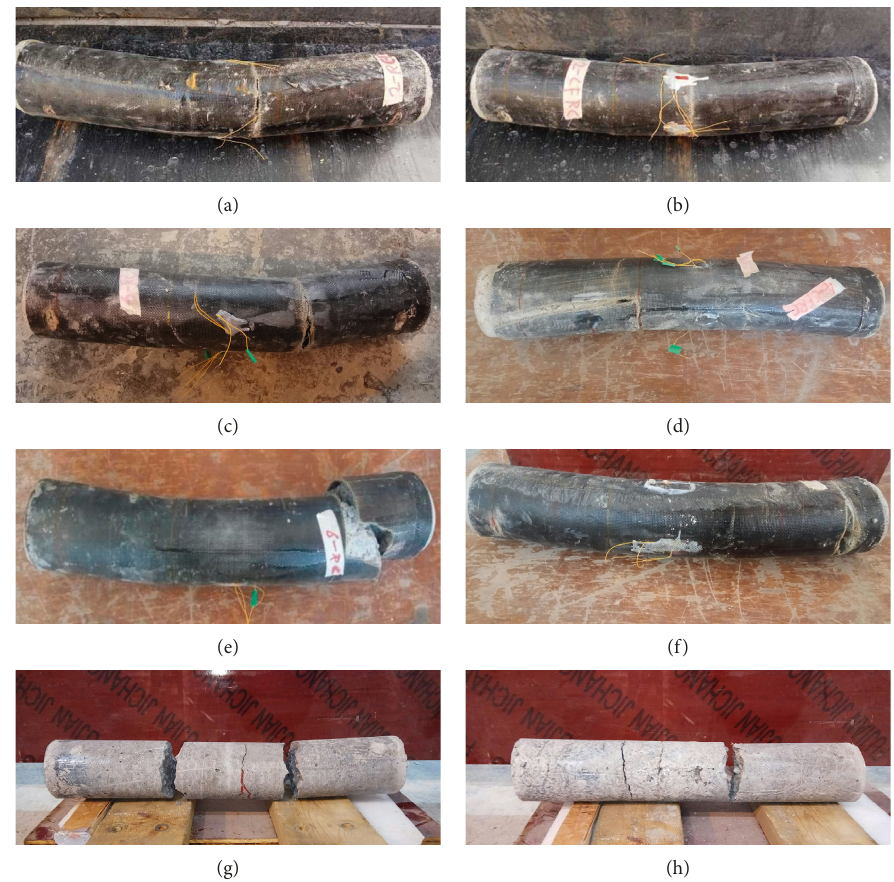
Figure 5: Failure modes. (a) 2L-BFRP-PC. (b) 2L-BFRP-CFRC. (c) 4L-BFRP-PC. (d) 4L-BFRP-CFRC. (e) 6L-BFRP-PC. (f) 6L-BFRP- CFRC. (g) PC core. (h) CFRC